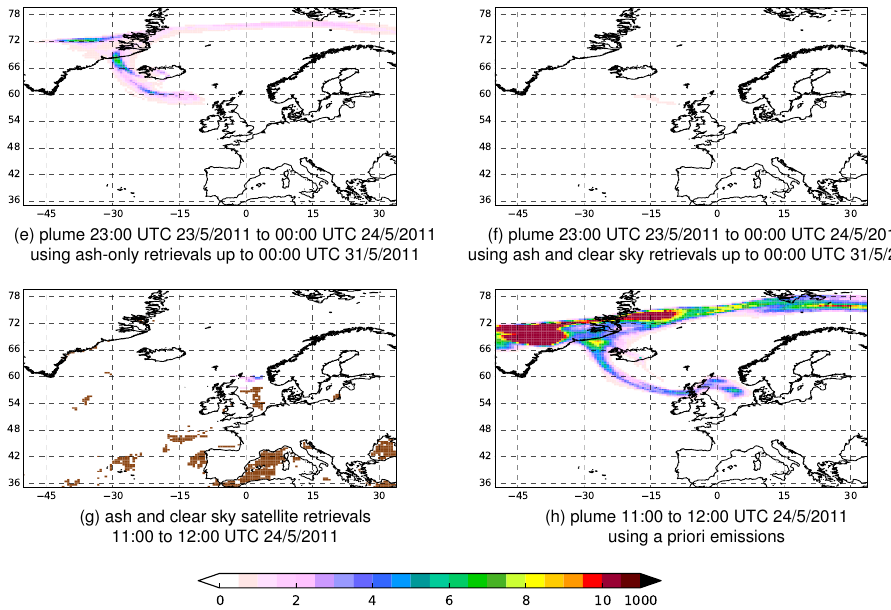
Run Date: February 28, 2018 Figure 10. The Grímsvötn ash cloud (column load contribution from the 1–30 µ m size range, g m averaged between ( a – f ) 23:00 UTC on 23 May 2011 and 00:00 UTC on 24 May 2011 and ( g , h ) 11:00 and 12:00 UTC on 24 May 2011. ( a , g ) show the ash cloud as observed by satellite (ash and clear skies, with clear skies shown in brown; none of the ash retrievals reach the brown part of the colour scale so all brown pixels are clear skies); ( b , h ) show the ash cloud as predicted by NAME with a priori mean emissions; and ( c – f ) show the ash cloud as predicted by NAME using various inversion emission Run Date: March 23, 2018 Run Date: March 23, 2018 profiles as